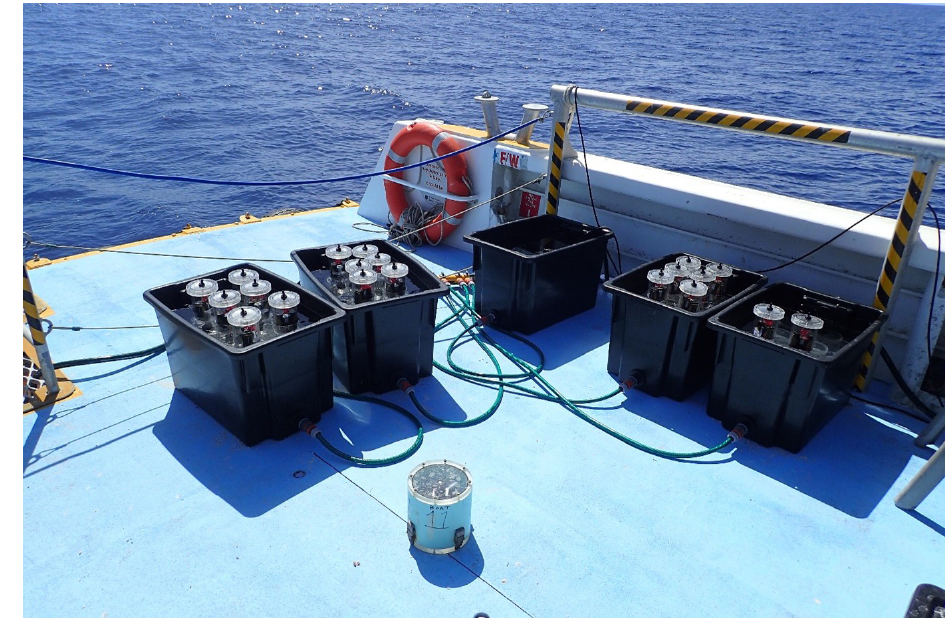
Figure 2. Experimental setup of respirometry incubations for Browse Island coral and macroalgae.